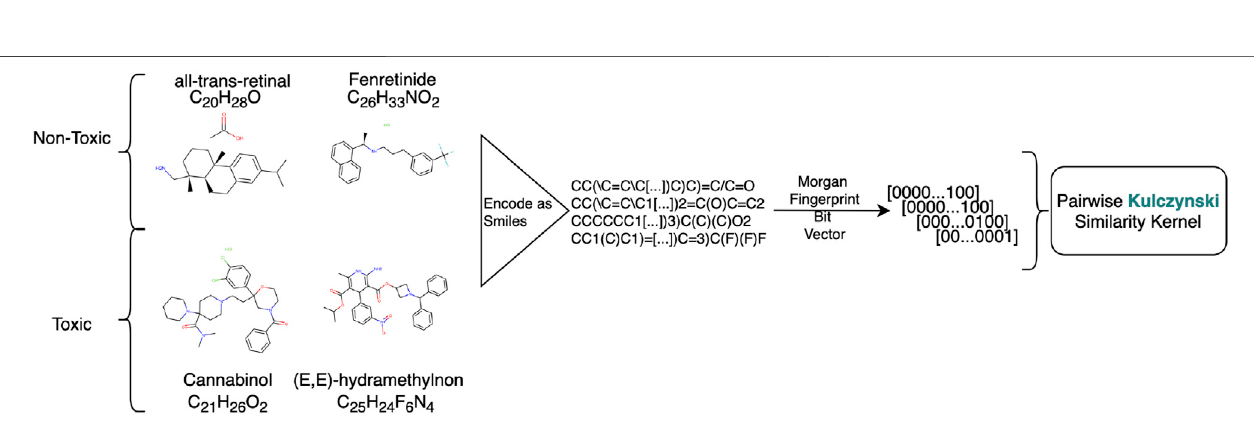
FIGURE2| Preprocessingwork fl owforcreatingtheTox-21datasets. ChemicalsrepresentedasSMILEcodesaretranslatedtoMorganFingerprints.Thekernelis created by using an application related pairwise similarity measure on the Morgan Fingerprints, in this case so-called Kulczynski .